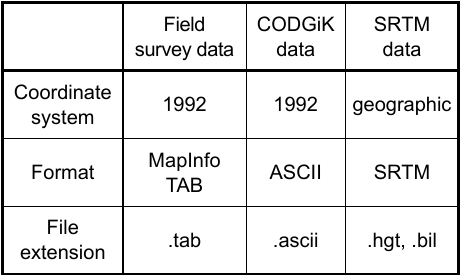
Tab. 1. Source data used for elaboration of a terrain model of the Bezmiechowa airfield and the surrounding